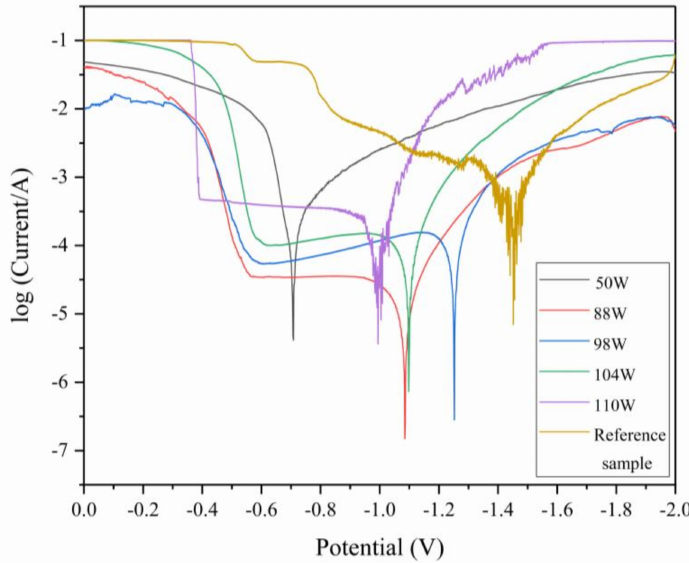
Figure 13. Potentiodynamic polarization curves of aluminium alloy after laser cleaning under di ff erent powers in 3.5 wt.% sodium chloride